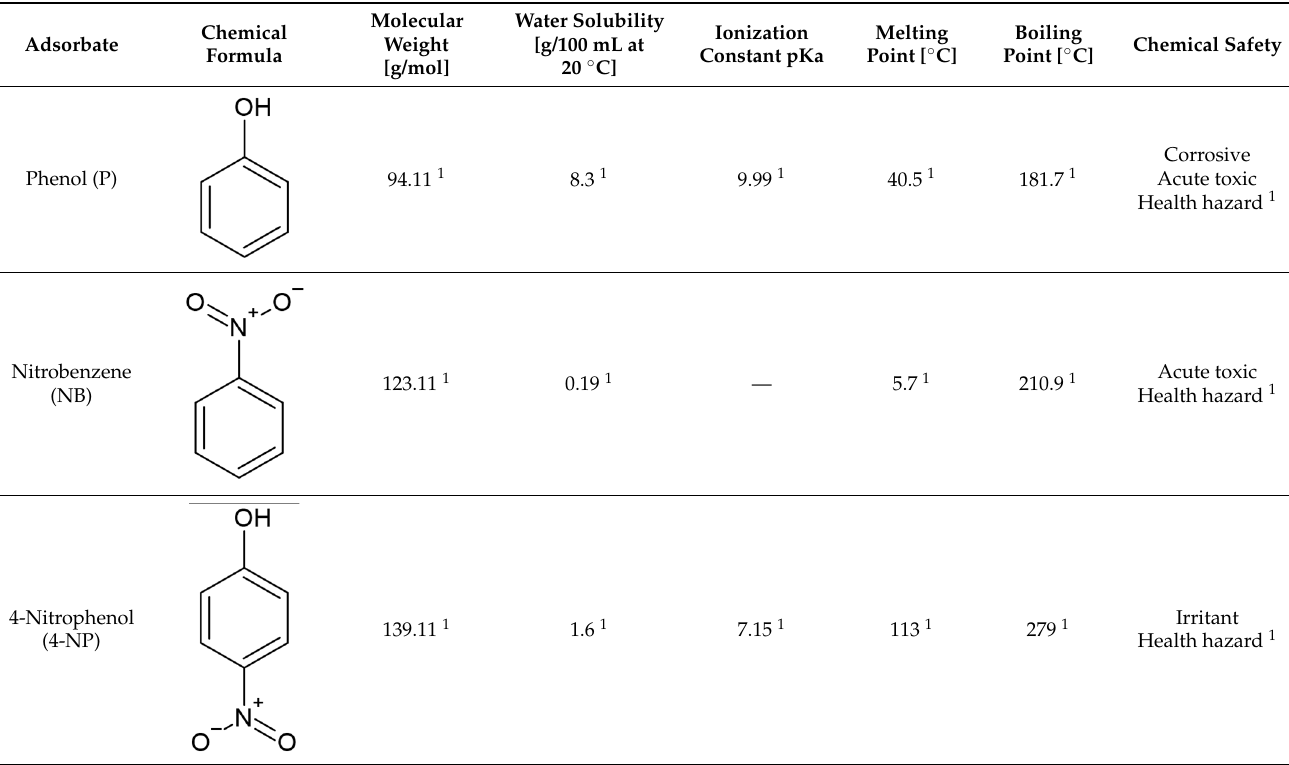
Figure 18. The chemical structure of inorganic ( a ) and organic ( b ) components of hybrid materials as well as the schematic structure of the copolymer ( c ). Table 7. The physicochemical properties of used adsorbates.